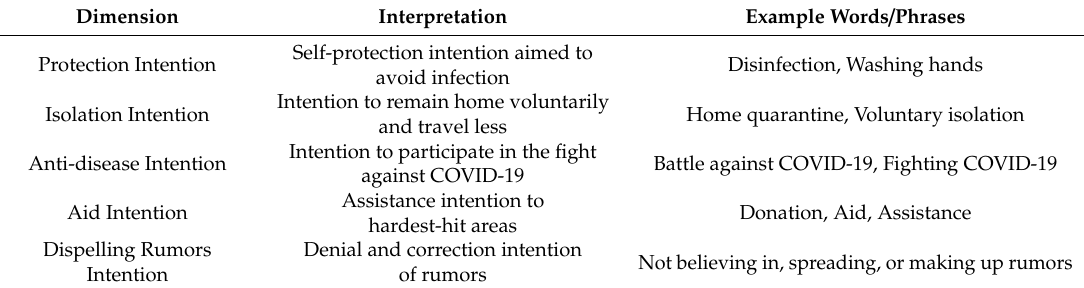
Table 4. Details of behavioral intentions.